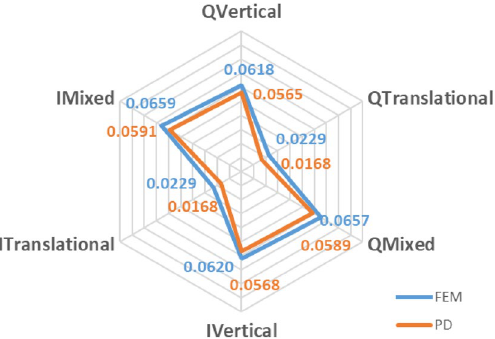
Figure 5. Comparison between FEM and PD in terms of maximum displacements in